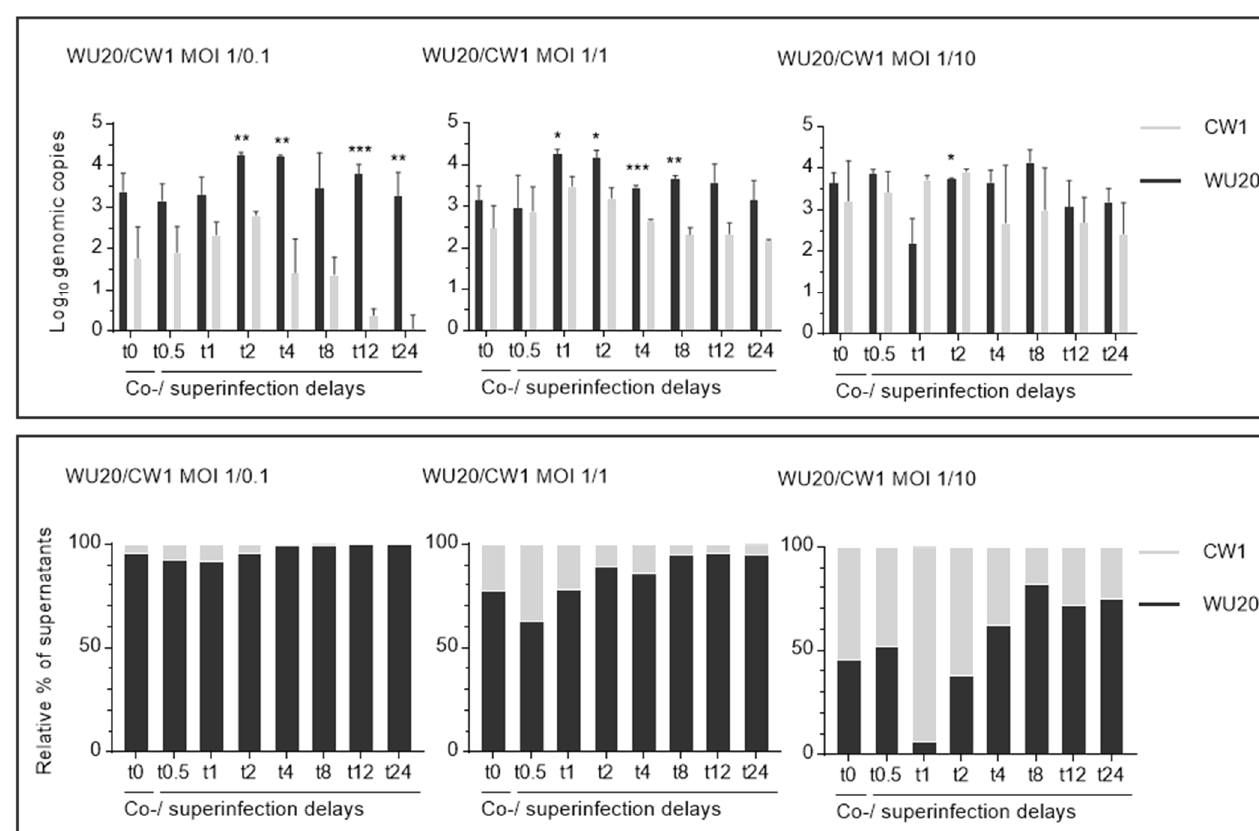
Figure 2. Genomic quantification on 5 ′ genome ends establishing raw genomic copy numbers (top) and relative proportions of mean genomic copies (below) of co- or superinfecting murine noroviruses MNV-1 WU20 and CW1 in viral progenies 24 h post co- or superinfection. Genomic copy numbers and their relative proportions resulting from one co-infection (t0) and seven asynchronous infections (primary infection: WU20; superinfection at half-hour to 24-h delays (t0.5 to t24): CW1) are shown. Varying multiplicities of infection (MOI) were analysed; the MOI of primary infecting WU20 remained stable at 1 throughout all assays while the MOI of superinfecting CW1 varied between 0.1 (left panels), 1 (middle panels), and 10 (right panels). Black bars represent WU20, grey bars represent CW1. Differences in yield between mean WU20 and CW1 genome copies were analysed using GraphPad Prism 7 (Graph-Pad Software) and p values were determined using two-sided unpaired-sample t tests, where *** p ≤ 0.001, ** p ≤ 0.01, and * p ≤ 0.05.